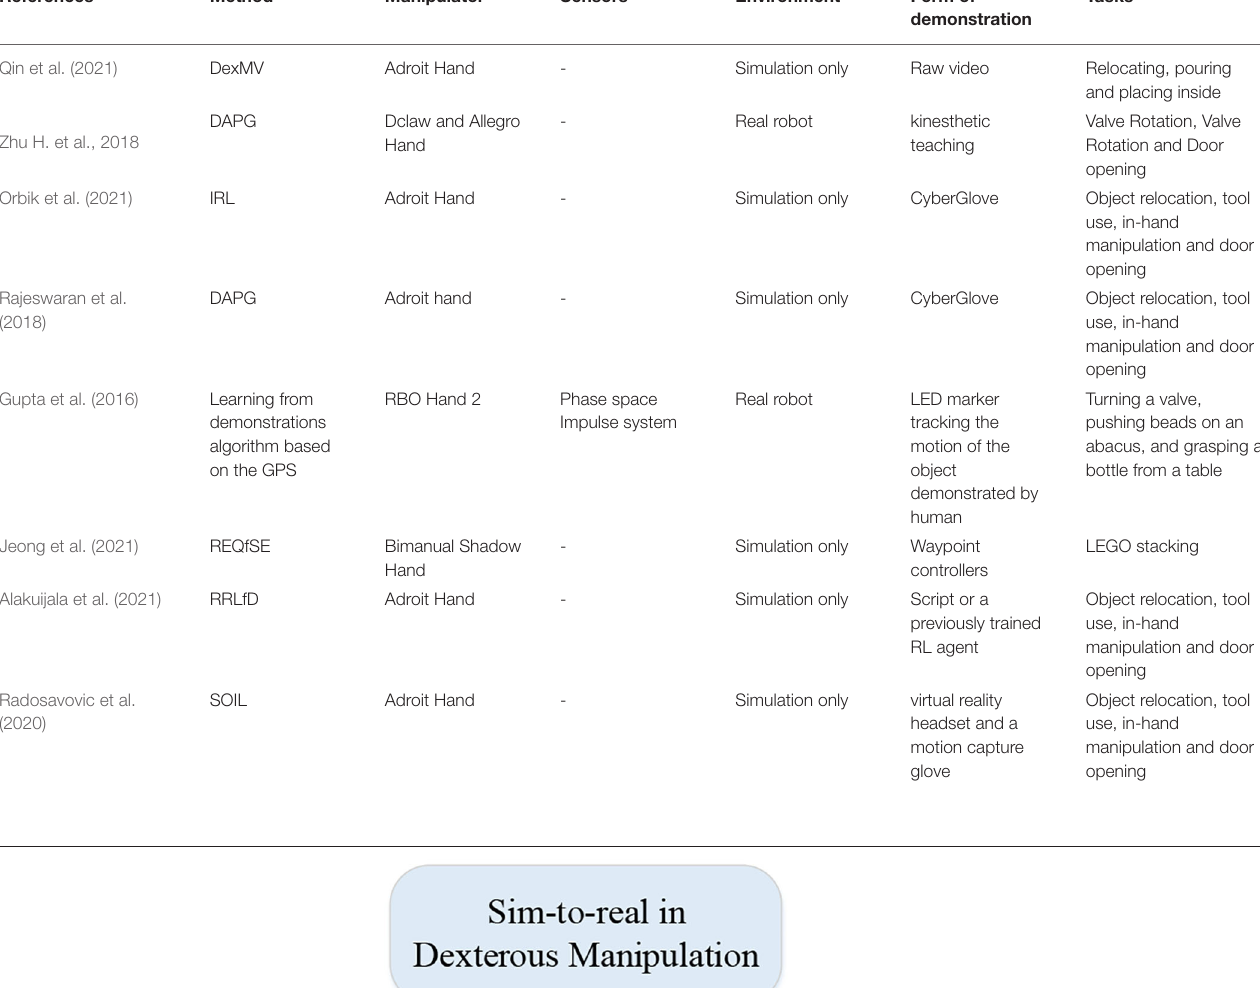
TABLE 6 | Overview of the dexterous manipulation solved by RL with a demonstration.